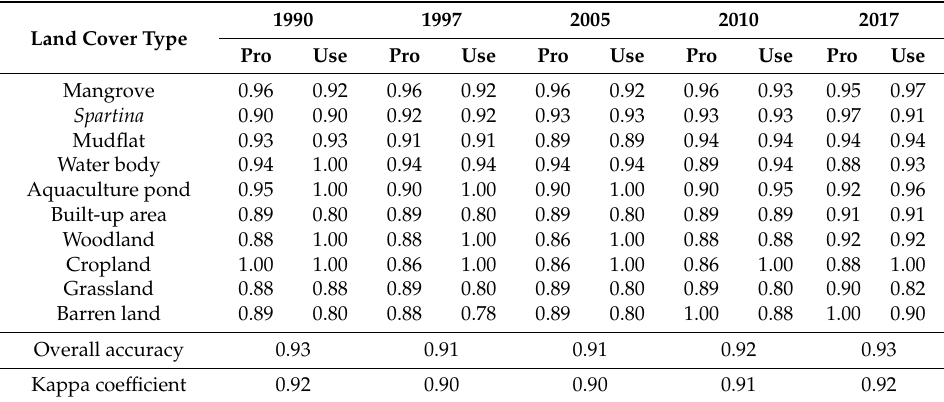
Table 3. Summary of land cover classification accuracies from 1990 to